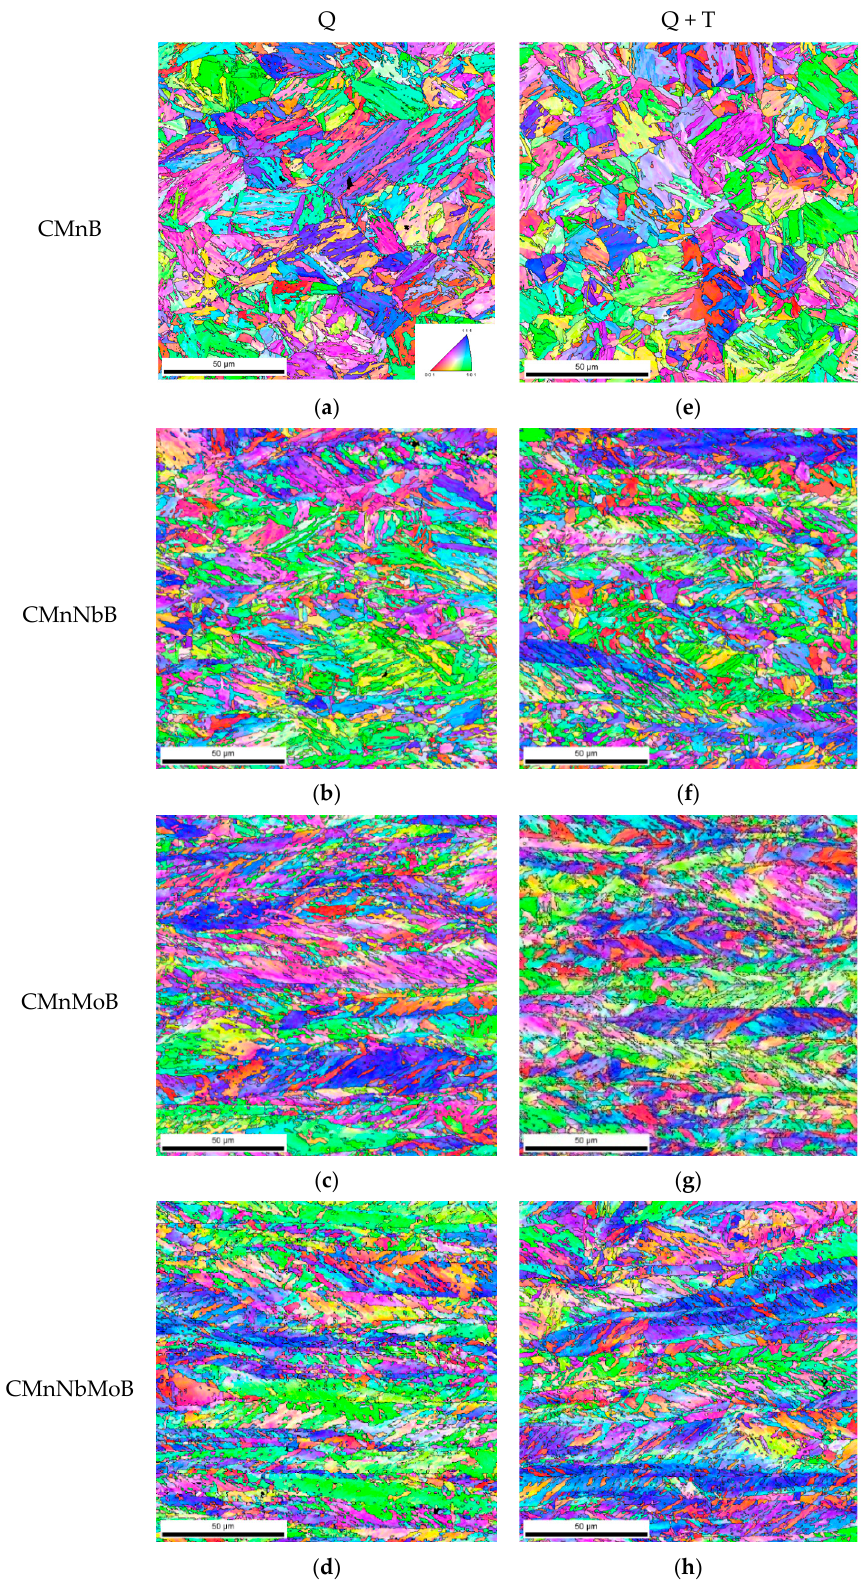
Figure 4. Inverse Pole Figure (IPF) maps corresponding to ( a – d ) Q and ( e – h ) Q + T states.